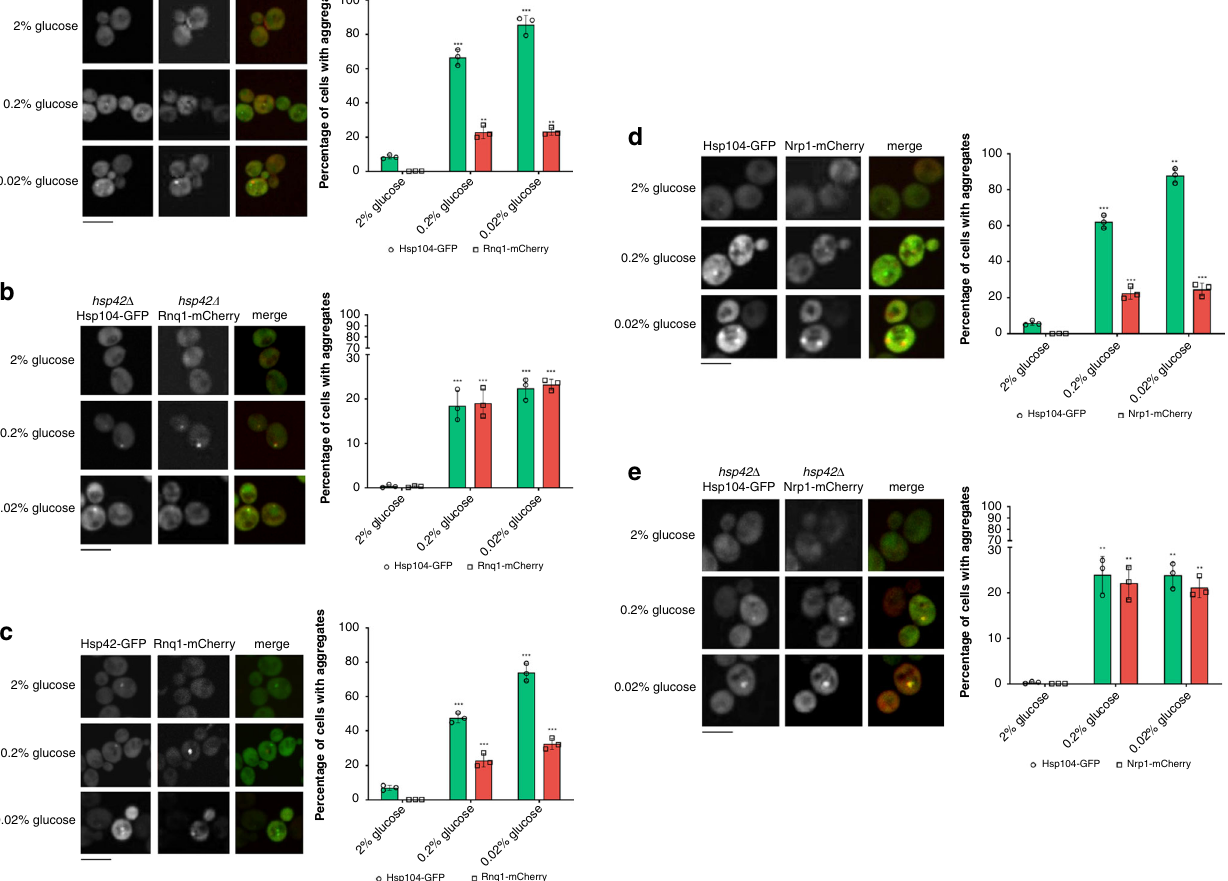
Fig. 5 Stress granules are formed during glucose starvation. a On average, 22% of cells had an Rnq1-mCherry aggregate during glucose starvation. b In hsp42 Δ background, the abundance of Hsp104-GFP containing aggregates is reduced to ~20% compared to the WT strain. Rnq1-mCherry aggregates are present in ~25% of cells during glucose starvation. c Hsp42-GFP aggregates are present in ~50% and ~75% of cells at 0.2% and 0.02% glucose, respectively. d In WT background, ~25% of cells display an Nrp1-mCherry-tagged compartment during glucose starvation. e In hsp42 Δ background, an average of 25% of cells remain with Hsp104-GFP aggregates and ~22% with Nrp1-mCherry puncta during glucose starvation. For all panels, n = 1000 cells were screened for aggregates starting from three independent exponential yeast cultures for each condition. Bar height represents mean ± SD from three separate cultures, each performed in triplicate. The mean of three technical replicates for each biological replicate is displayed as single data points. *** p < 0.001; ** p < 0.01; * p < 0.05 (one-way ANOVA plus Tukey post hoc). The images are representative of three biological replicates, each in three technical replicates. The black bar represents 8 µ